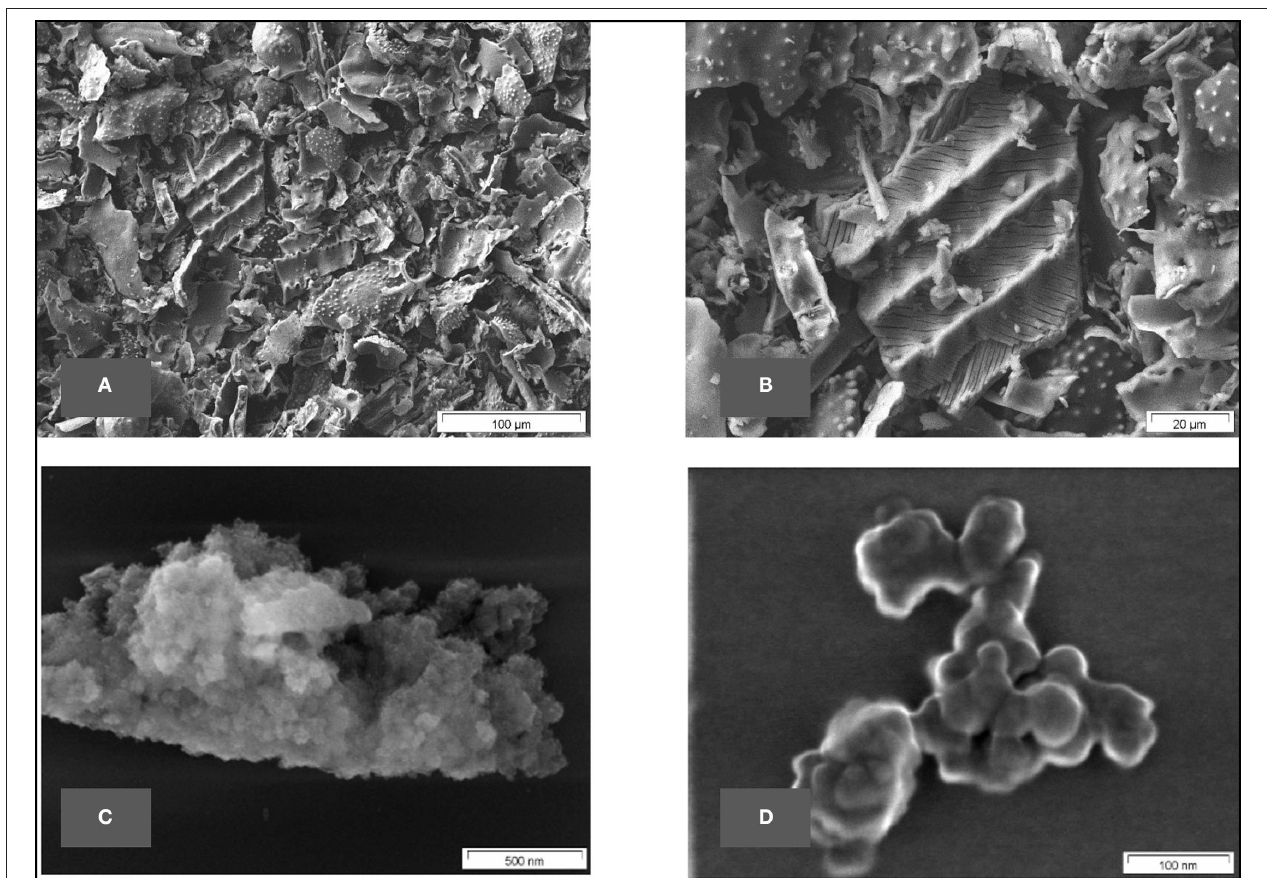
FIGURE 4 | (A–D) SEM micrographs of final sample of common